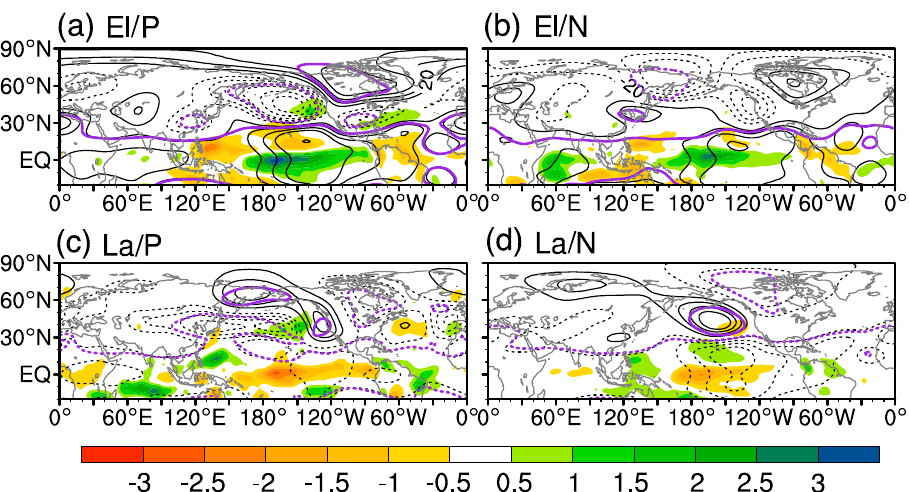
Figure 3. Composite precipitation anomalies (shadings, units: mm d − 1 ) and 200-hPa height anomalies (contours; units: gpm; interval: 10) during El Niño winters when the PDO is in its ( a ) positive and ( b ) negative phases and those during La Niña winters when the PDO is in its ( c ) positive and ( d ) negative phases. Purple contours mark the height anomalies at 90% confidence level.